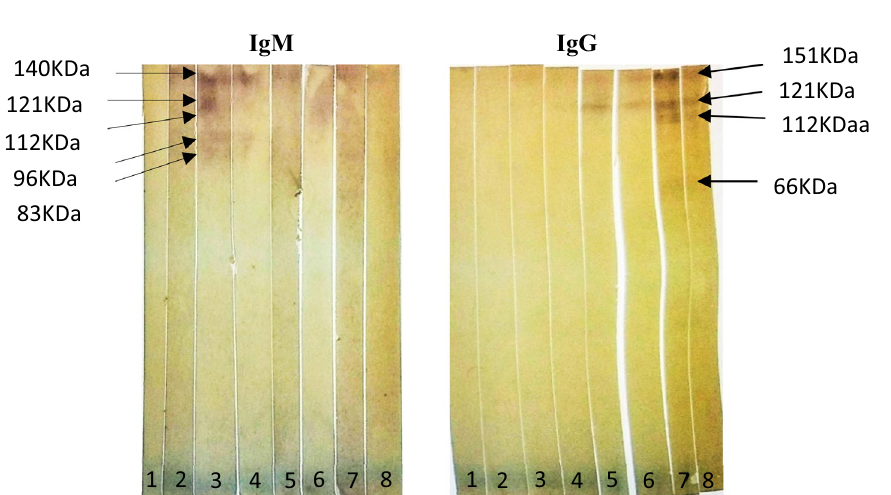
Figure 5. Western blots for IgM and IgG secondary antibodies with, (1) positive human serum, (2) day 0 or negative rat serum, (3) day 7 rat serum, (4) day 14 rat serum, (5) day 21 rat serum, (6) day 28 rat serum, (7) day 35 rat serum, (8) day 42 rat